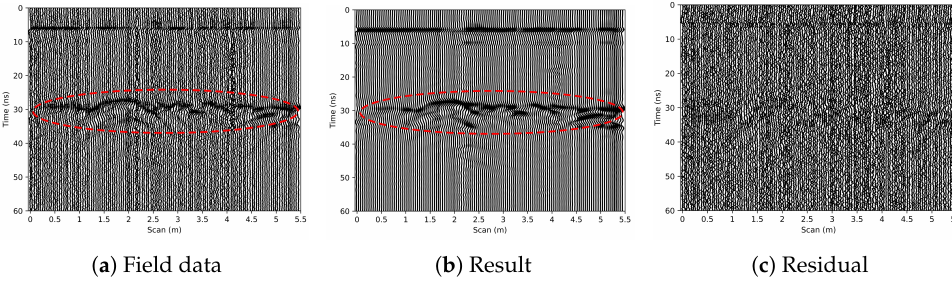
Figure 19. Noise attenuation result and residual of the GPR profile from the field